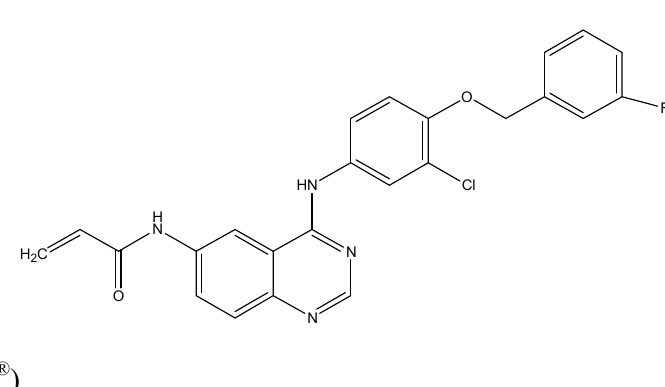
Figure 7. Structure of